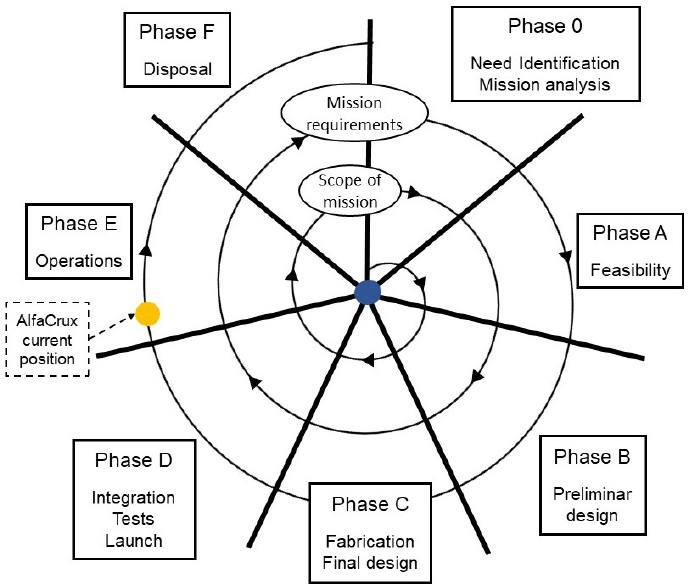
Figure 1. AlfaCrux mission life cycle in the development